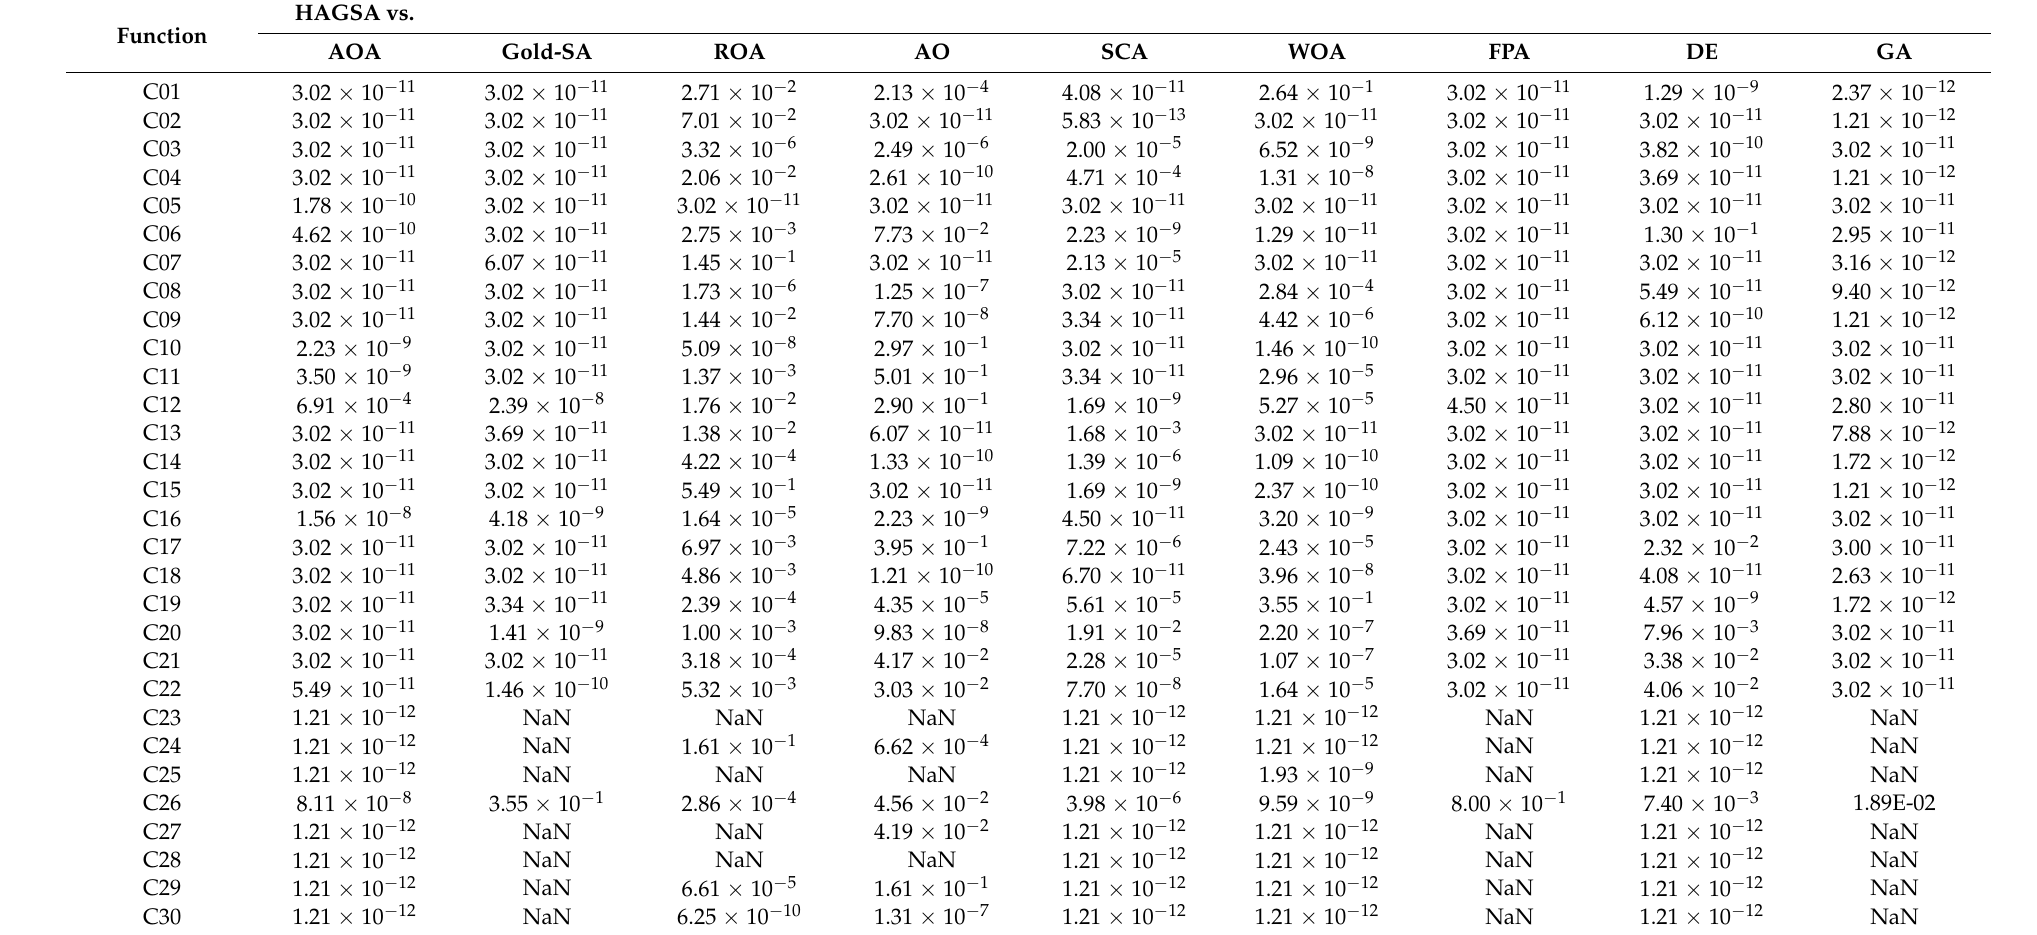
Table 4. Statistical results of Wilcoxon rank-sum test obtained by each algorithm.